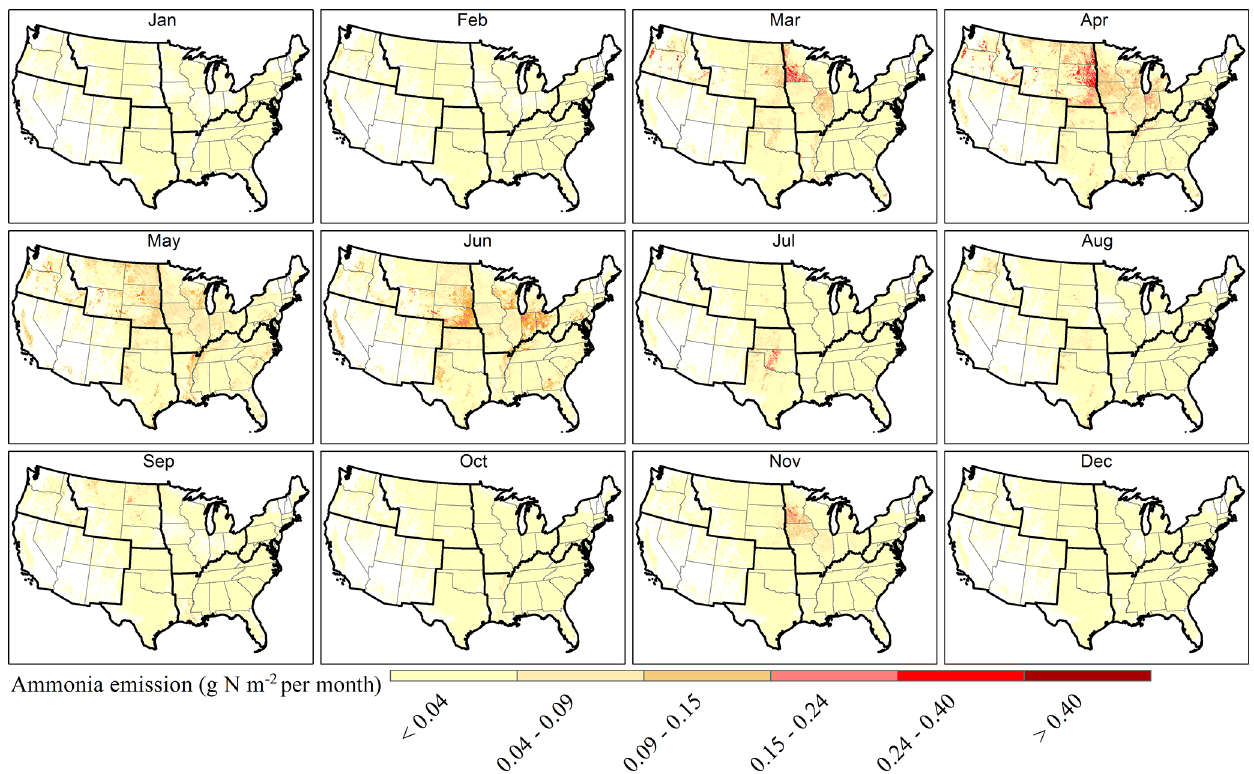
Figure 5. Spatial distribution of monthly estimated NH 3 emission across the US in